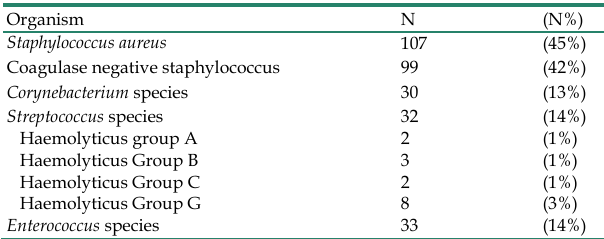
Table 2. Predominant organisms cultured from intraoperative samples during the first debridement.